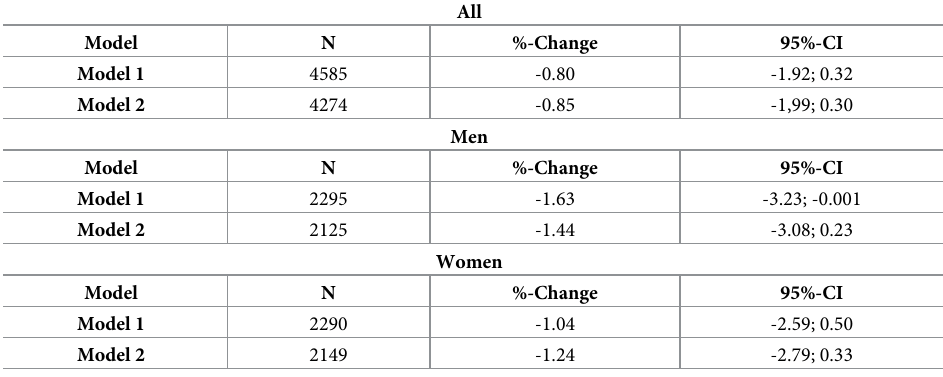
Table 3. Effect size estimates as percentage change in NT-proBNP per year of education and 95% confidence intervals (95%-CI) for the main analysis population and stratified by sex.